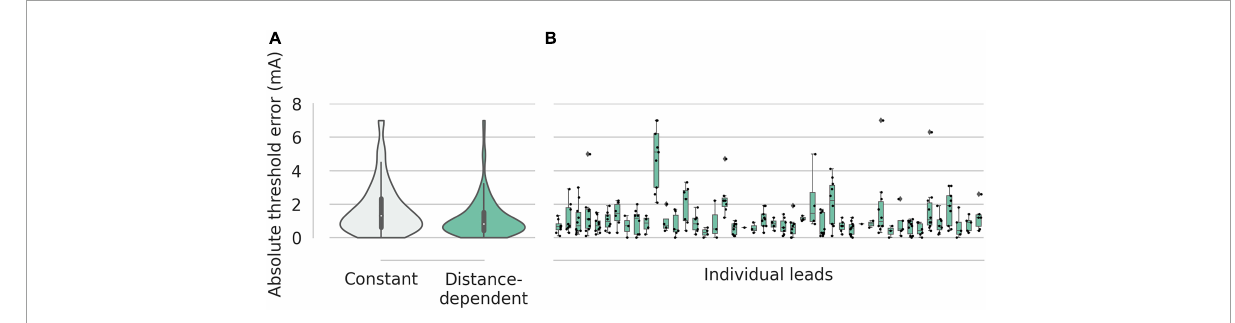
FIGURE3 Absolute errors for the effect thresholds. (A) Suggestions with the constant desired overlap volume had a mean error of 1.6 mA. Suggestions with the distance-dependent desired overlap volume had a mean error 1.2 mA. (B) For suggestions with distance-dependent desired overlap volume, the errors of the individual leads are shown as box plots with a range of 0.3–4.8